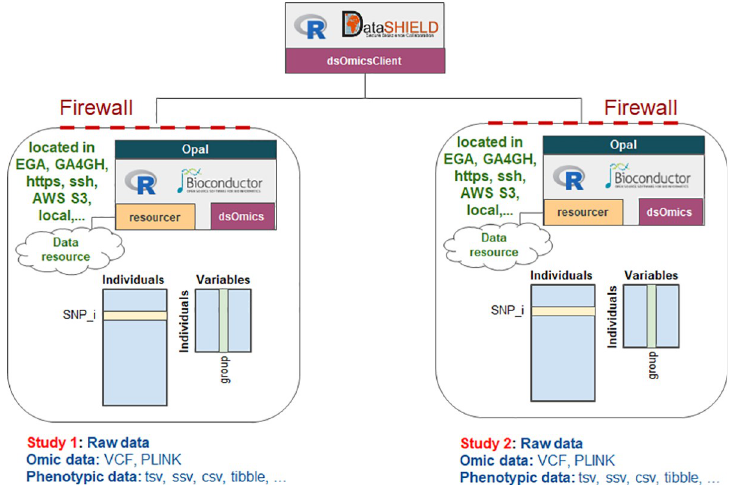
Fig 2. Scheme of DataSHIELD implementention of genomic data analysis. The dsOmics package contains functions to perform non-disclosive data analyses of resources encoding genomic data that are managed within Opal using the resourcer package. Genomic data normally have two pieces of information, one corresponding to variants (e.g. SNPs) and another for phenotypic data (grouping variable, outcome, covariates, ... ). Both can be stored in different resources. BAM/VCF/PLINK for SNPs and text/csv file for phenotypes and covariates. This package should be installed in the Opal server along with their dependences. The package dsOmicsClient must be available in the client side and contains functions that allow the interaction between the analysis computer and the